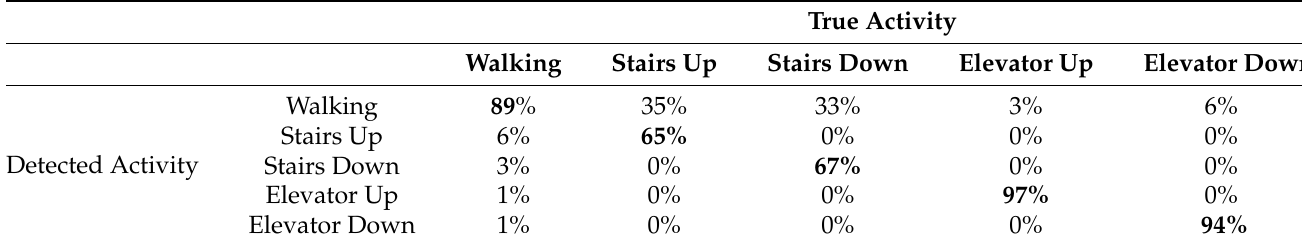
Table 4. Confusion matrix for real-time floor transition detection.